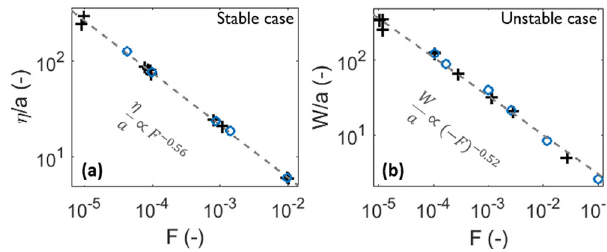
Fig. 6 Scaling of the fl ow patterns with the fl uctuation number. Illustration of expression (10), which is here the most general formalism for the scaling of the size of the fl ow pattern with the fl uctuation number, as de fi ned by (11). The numerical results of Figs. 4 and 5 are shown (crosses and circles) and fi tted with power laws (dotted line) for, respectively, the stable ( a ) and the unstable ( b ) drainage cases. Crosses represent simulations with only a structural gradient in pore threshold ( G = 0), whereas circles mark simulations also including an external fi